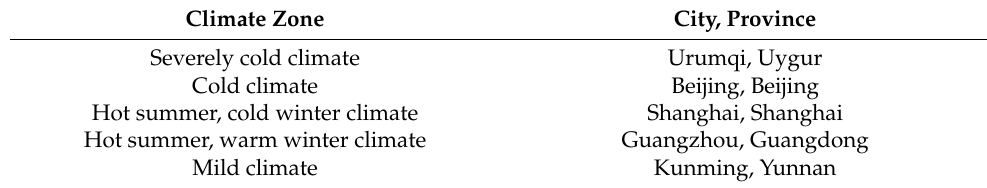
Table 1. Five distinctive climate zones in